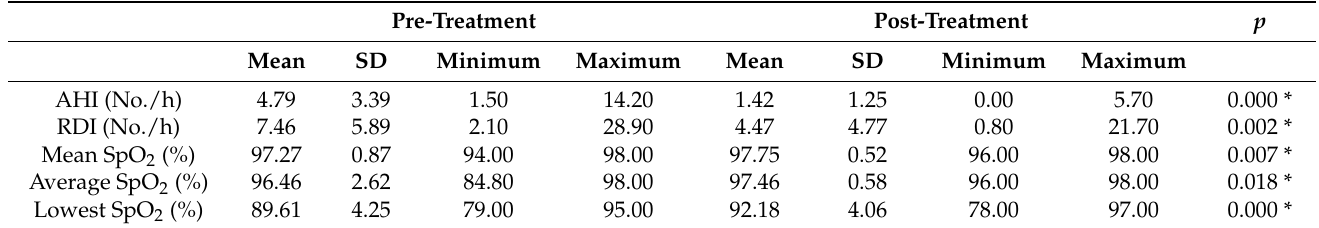
Table 3. Pre- and post-treatment polysomnographic measures in the responsive group. Pre-Treatment